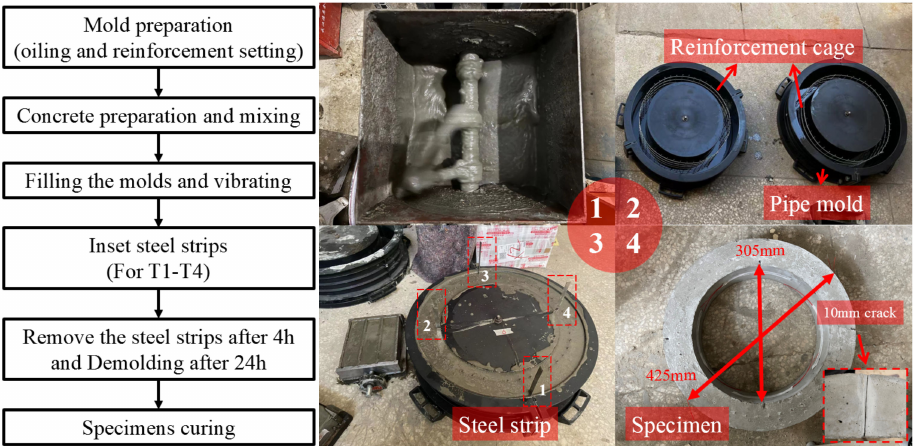
Figure 3. Procedures of RCP casting. (1. Mixing concrete; 2. Oiling mold and setting